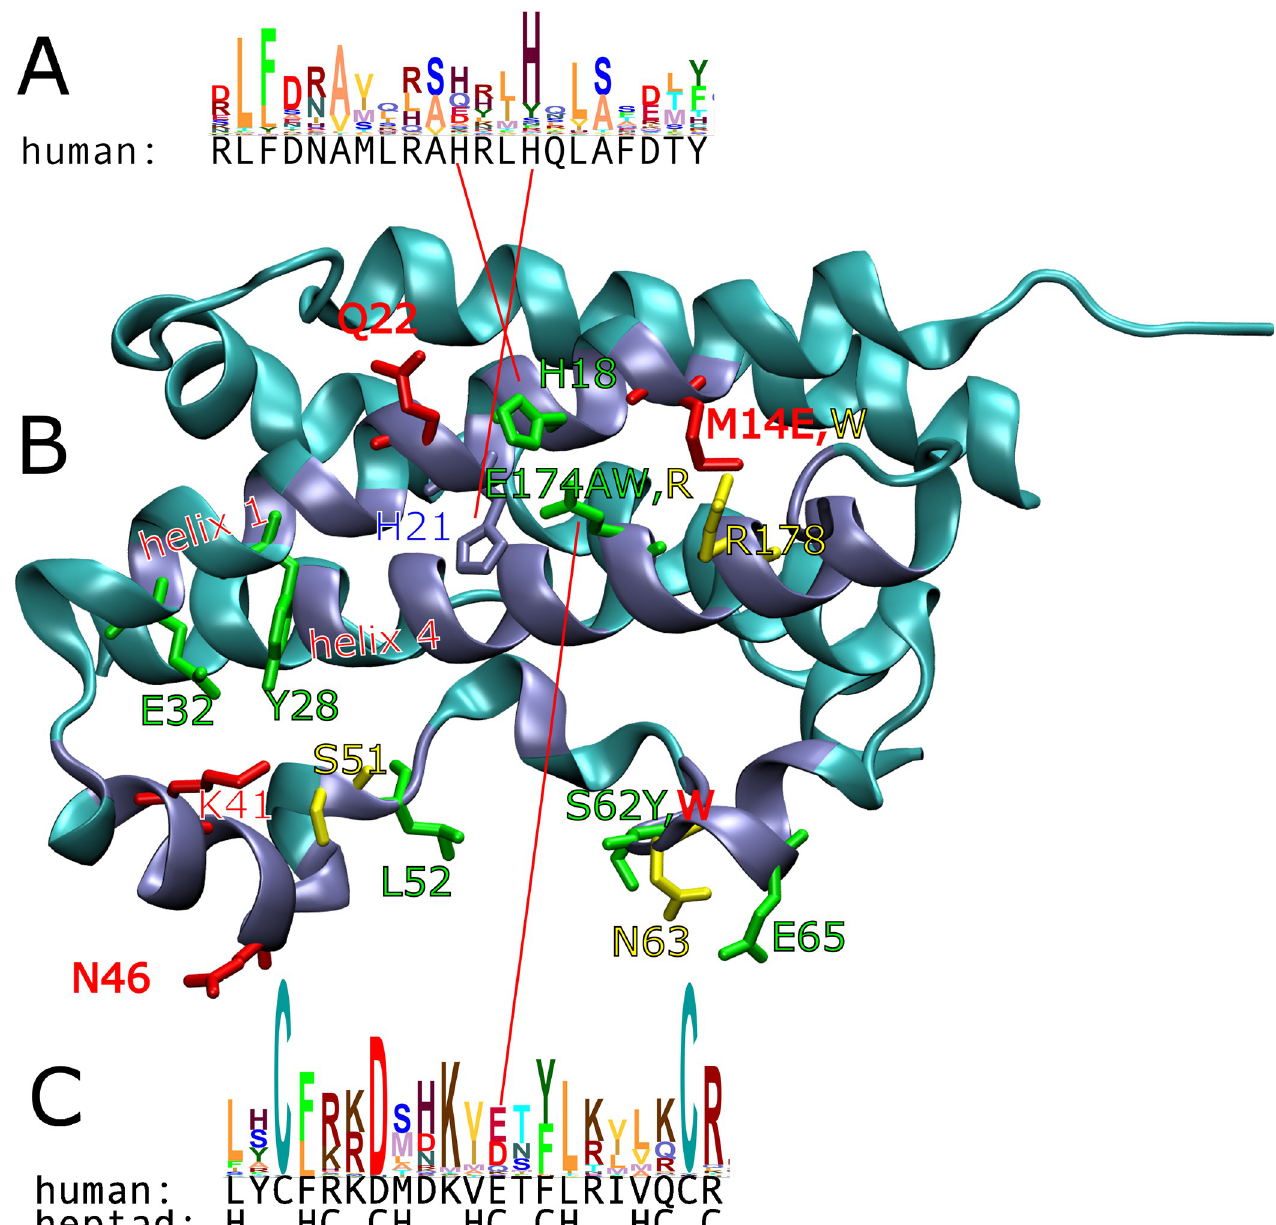
Fig 1. Conserved position E174 is part of the zinc binding triad and obeys the heptad pattern. Coiled-coils tend to follow the heptad pattern of HxxHCxC (H = hydrophobic, C = charged). (A) Helix 1 appears coiled with its antiparrallel partner helix 4. However for the former no coiled-coil signal was found by COILS, MultiCoil, or other expasy coiled-coil predictors. H18 and H21 are conserved (multiple sequence alignment from PFAM family PF00103, full alignment, profile generated with Skylign, vertical size proportional to information) and part of the zinc binding triad. Thus the triad appears important for coiled-coiling (B) in the hGH monomer. Site 1 residues are shown in iceblue, remaining residues in cyan cartoons. At several positions, we generated mutations with binding kinetics similar to those of WT (green labels). We identified a second cluster of mutations with similar koff, but much slower kon (red labels). Mutants with kinetics that did not fall into either cluster are labelled in yellow. At some positions different substitutions were tested which produced different kinetics (M14E,W, S62Y,W, E174A,W,R). (C) Helix 4 follows the heptad pattern closely, and is predicted to be in a coiled-coil by COILS [7]. E174 is conserved and part of the zinc binding